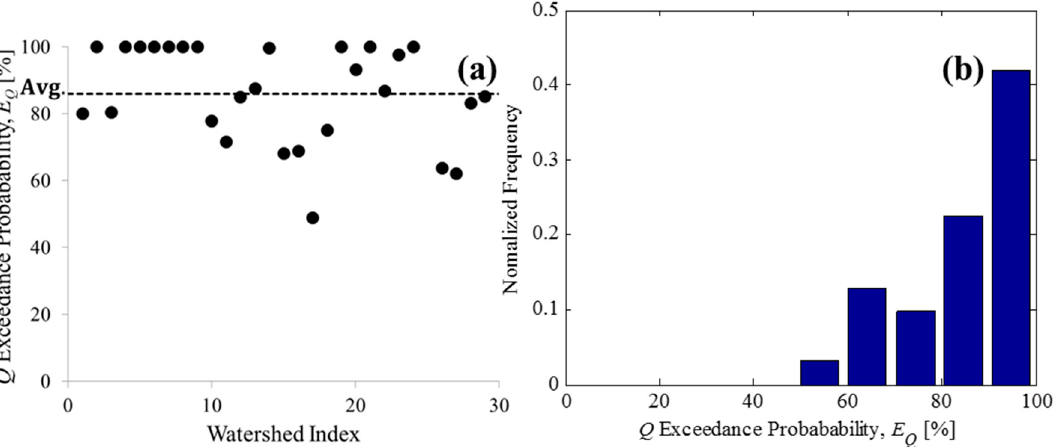
Figure 7. Streamflow exceedance probability of the perennial streams and its normalized frequency distribution. ( a ) Streamflow exceedance probability ( E Q ) of the perennial streams in the study watersheds using the relationship between the wet channel ratio ( α W ) and E Q ; and ( b ) normalized frequency distribution of E Q for all of the study sites.